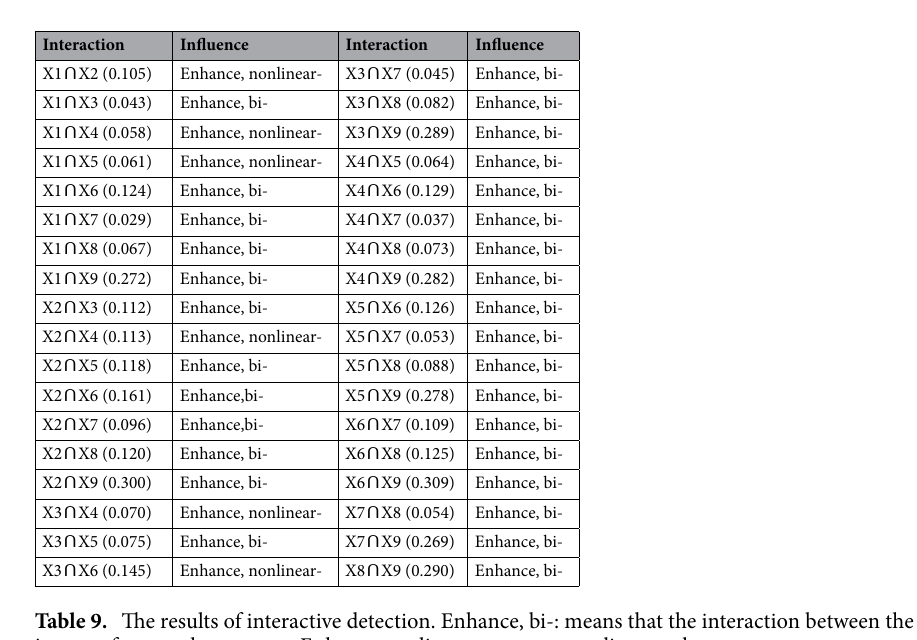
Table 9. The results of interactive detection. Enhance, bi-: means that the interaction between the two factors is a two-factor enhancement, Enhance nonlinear: means a non-linear enhancement.